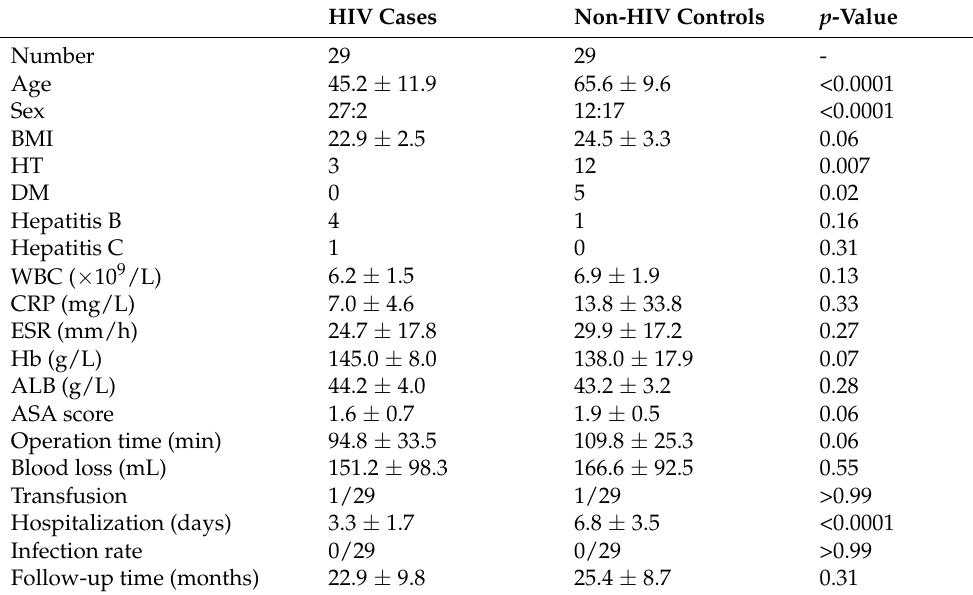
Table 2. Statistical analysis of perioperative indicators between HIV patients and non-HIV patients. HIV Cases Non-HIV Controls p